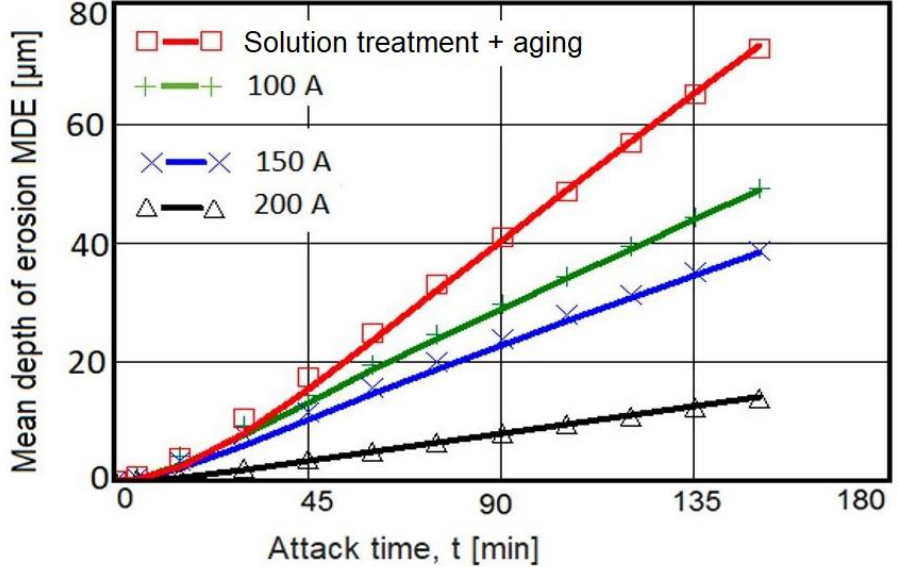
Figure 7. Evolution of the mean penetration depth of erosion with the cavitation attack time.